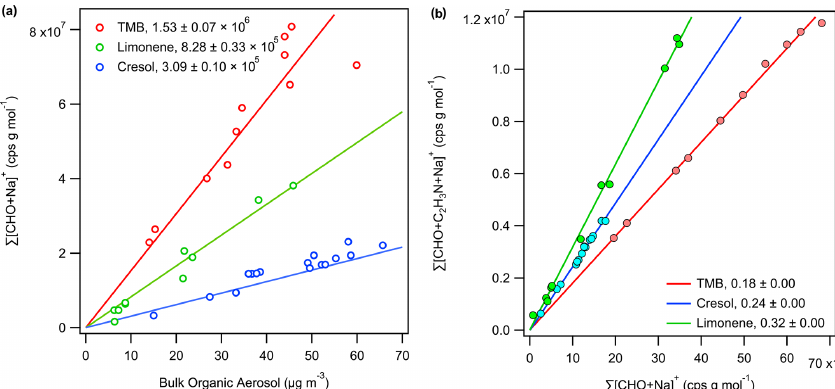
Figure 5. Correlation of (a) the total EESI-TOF [ M + Na ] + ion intensities with the bulk organic aerosol concentration as determined by the AMS and (b) the sum of background-subtracted, MW-weighted EESI-TOF [ M + C 2 H 3 N + Na ] + and [ M + Na ] + signals observed during the seed injection periods, excluding any analytes observed in only one of the two forms, i.e. [ M + C 2 H 3 N + Na ] + or [ M + Na ] + . Linear ordinary least squares regression with a forced 0 intercept is applied to determine the bulk EESI-TOF response factor in (a) and the average ratio of [ M + C + Na ] + to [ M + Na ] + in (b) . For each species M , its EESI-TOF ion intensity measurement is weighted by its molecular 2 H 3 N